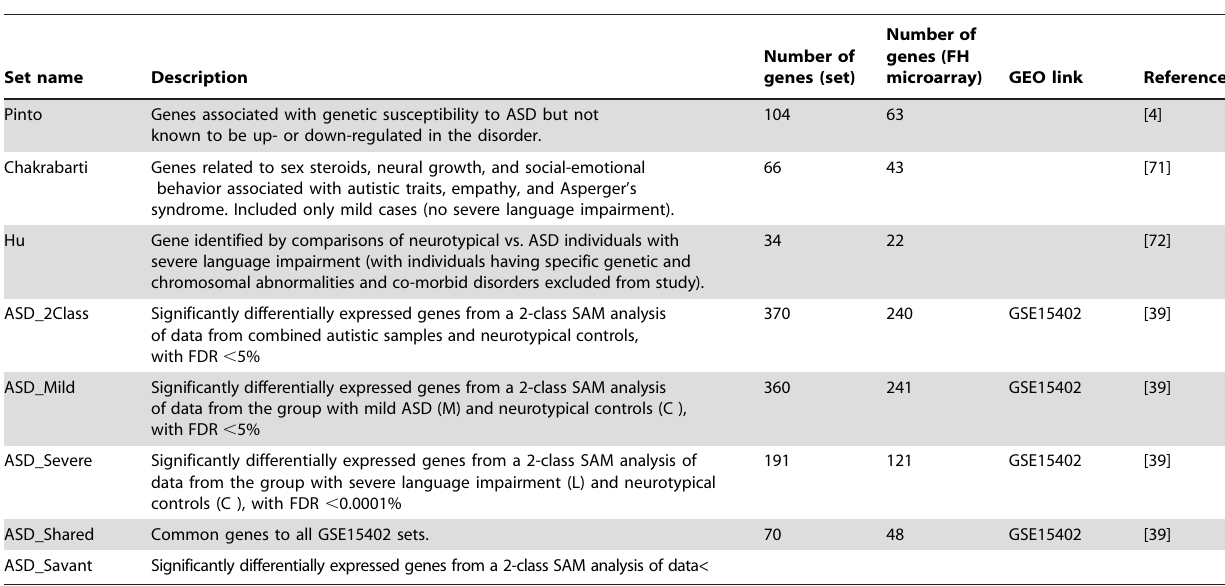
Table 3. ‘‘ASD’’: Collection of sets of genes associated with idiopathic autism.